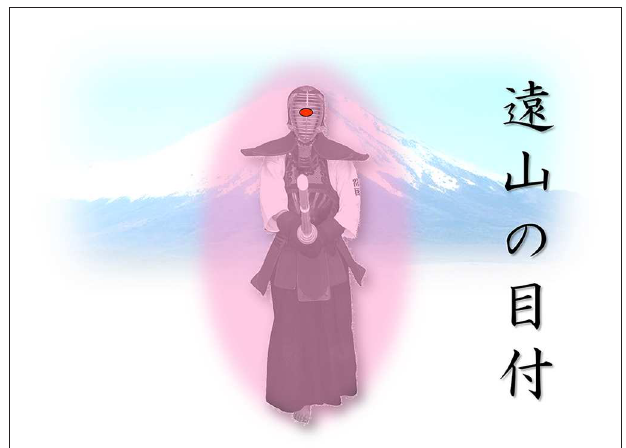
FIGURE 1 | The concept of “Enzan no Metsuke.” It is said that “Enzan no Metsuke” is one of the most important Waza whereby fighters look at their opponent with a gaze toward the mountains in the distance, taking in not only their opponent’s face but their whole body as well.